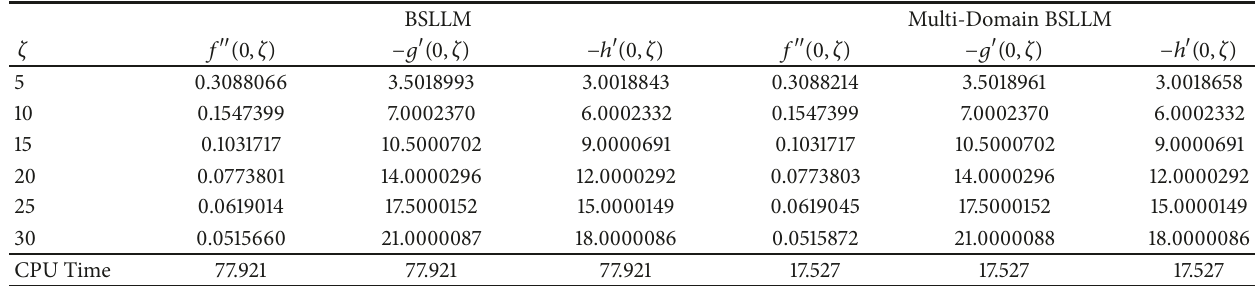
Table 4: Comparison of the MD-BSLLM and the BSLLM solution for 𝑓 󸀠󸀠 (0,𝜁) , −𝑔 󸀠 (0, 𝜁) , and −ℎ 󸀠 (0, 𝜁) : 𝑁 𝜂 = 60 , 𝑁 𝜁 = 5 , 𝑛 = 𝑤 = 1/2 , 𝑃𝑟 = 0.7 , 𝑆𝑐 = 0.6 , and 𝑧 = 40 .